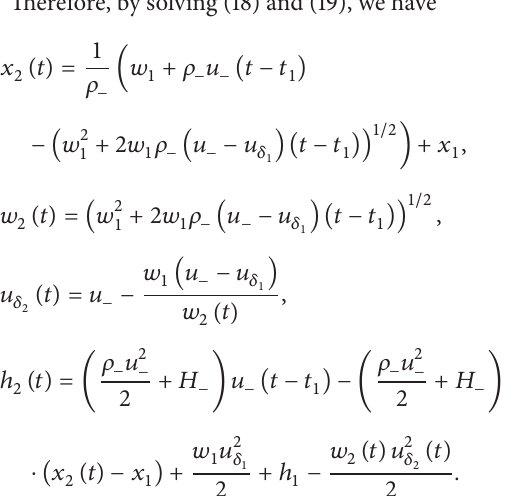
Figure 3: 𝑢 + > 𝑢 − > 𝑢 𝑚 .